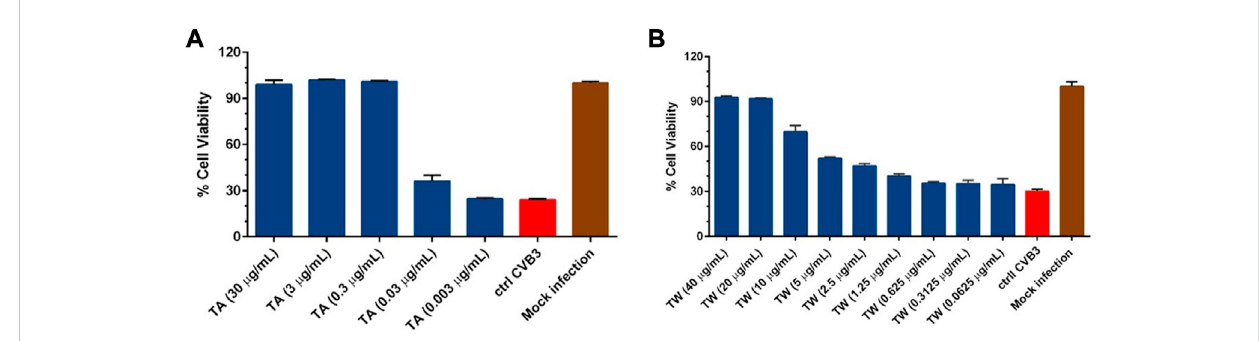
FIGURE 2 Testing the antiviral activity of (A) commercial tannic acid (TA) and (B) tannin-rich bark extract (TW) against enterovirus CVB3. Virus control and test samples are normalized against the mock infection. The results are the mean of three technical replicates. The results are expressed as average values + standard errors of the mean